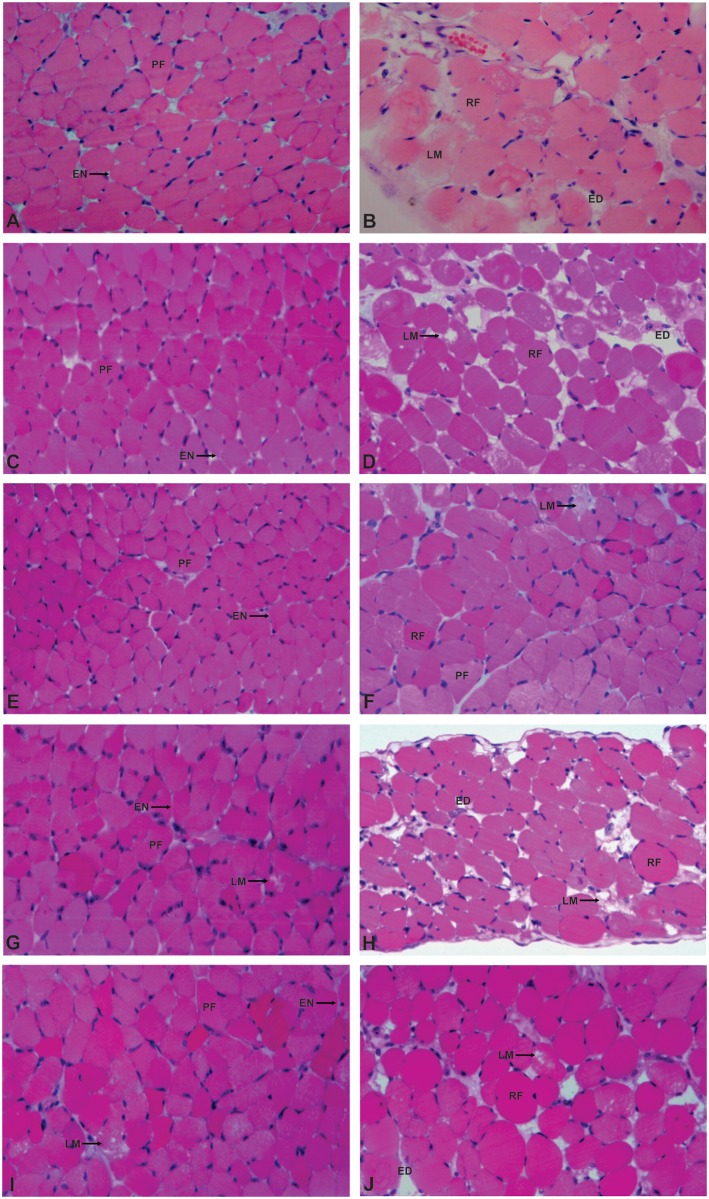
Light micrographs of mouse diaphragm muscles submitted to hematoxylin and eosin staining.Control muscle (A) and muscle exposed to caffeicacid (CA) and aristolochic acid (AA) (C, E, G and I) show fibers with normal appearance as evidenced by the polygonal aspect of fibers (PF) and endomysium (EN). A few fibers present loss of myofibrils in the muscle exposed to AA (G and I). (B) Muscle exposed to PrTX-I: edema (ED), round fibers (RF), some of which present loss of myofibrils (LM). (D, F, H and J) Muscle exposed to PrTX-I pre-incubated with CA and AA: The fibers have characteristics observed less frequently in the fibers treated with the PrTX-I alone, except in J, which occurred at similar frequencies.